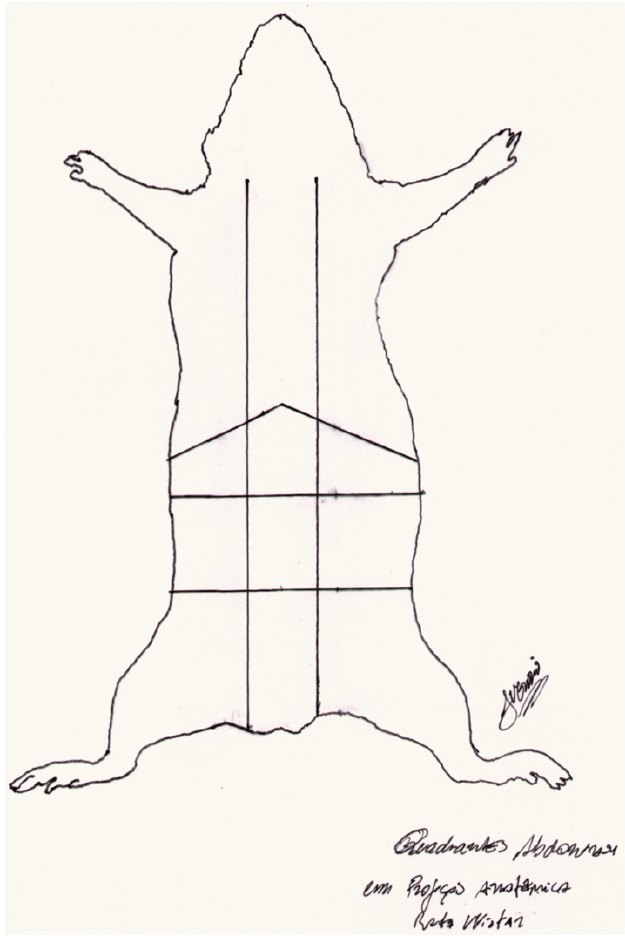
FIGURE 2 - Nine abdominal quadrants. Longitudinal divisions are defined by the hemiclavicular lines. Transversal divisions are defined by the lower L1 border, transpyloric plane, and line on the iliac crests on the lower L5